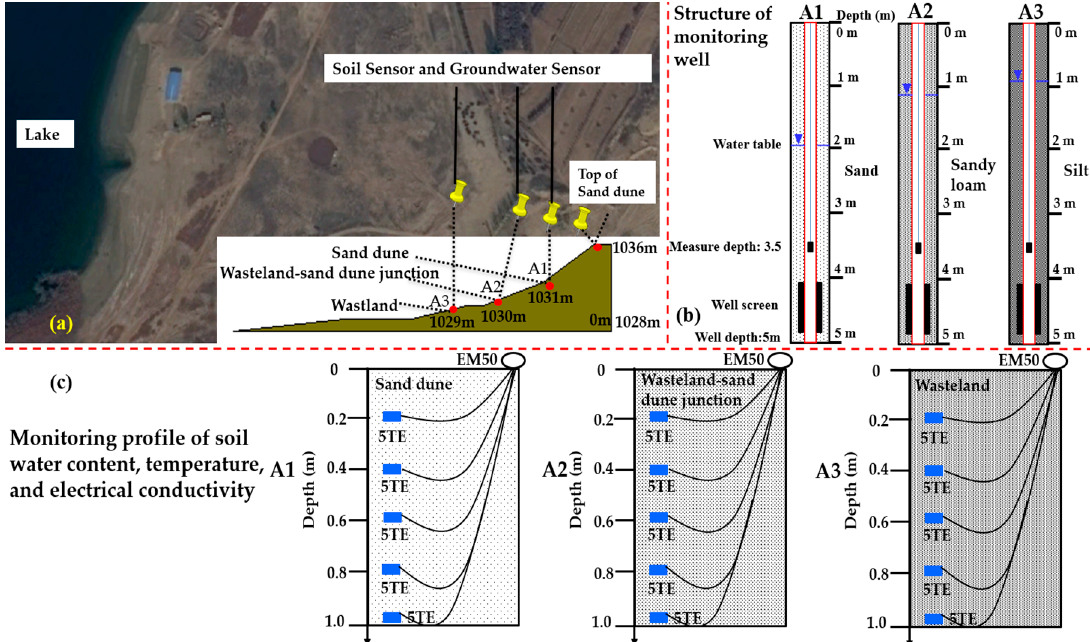
Figure 2. Map of study area. ( a ) Planar layouts of experiment design; ( b ) structure of monitoring well; ( c ) monitoring profile of soil water content, temperature, and electrical conductivity.